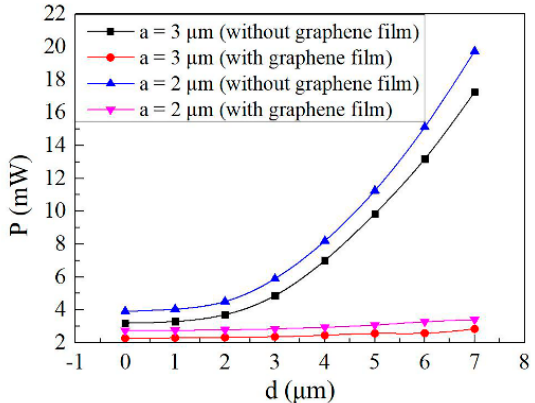
Figure 7. Calculated power consumption as a function of the horizontal distance between the center of the core layer and the electrode for a = 3 µ m and a = 2 µ m, respectively. The calculated response time and the power consumption with different electrode widths ( d = 4 μ m) are shown in Figure 8. Figure 8 shows that by reducing the width of the core layer from 4.5 to 1.5 μ m, the rise time was shortened from 75.8 to 55.1 μ s, the fall time was shortened from 188.2 to 174 μ s, and the power consumption was increased from 2.36 mW to 3.59 mW. It indicated that the small size of the core layer can achieve a fast response time. The large size of the core layer can realize low power consumption due to the small temperature change when phase change of π was realized. Figure 8. Calculated response time and the power consumption as a function of the electrode width ( d = 4 μ m). Figure 9 shows the response time curves of the side electrode TO switch with a graphene heating layer, which is simulated by finite element analysis software. The study method is “time dependent”, and a square wave with upper limit of 0.0007 is added in the TO switch. The rise and fall times were 64.5 μ s and 175 μ s with a d of 4 μ m, a of 2 μ m, ∆ T of 1.15 K, and P of 2.95 mW, respectively.